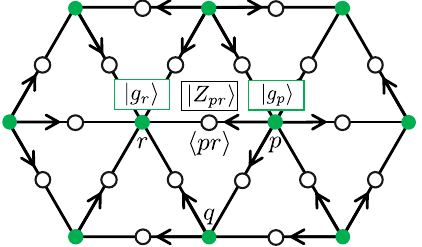
FIG. 3. The bosonic shadow model is defined on a Hilbert space with generalized G -spin d.o.f. at vertices and spin- 1 = 2 d.o.f. on links. This gives the total Hilbert space: ð ⊗ A basis is given by configuration states jf g statesforwhich g chosen for each link h pq i